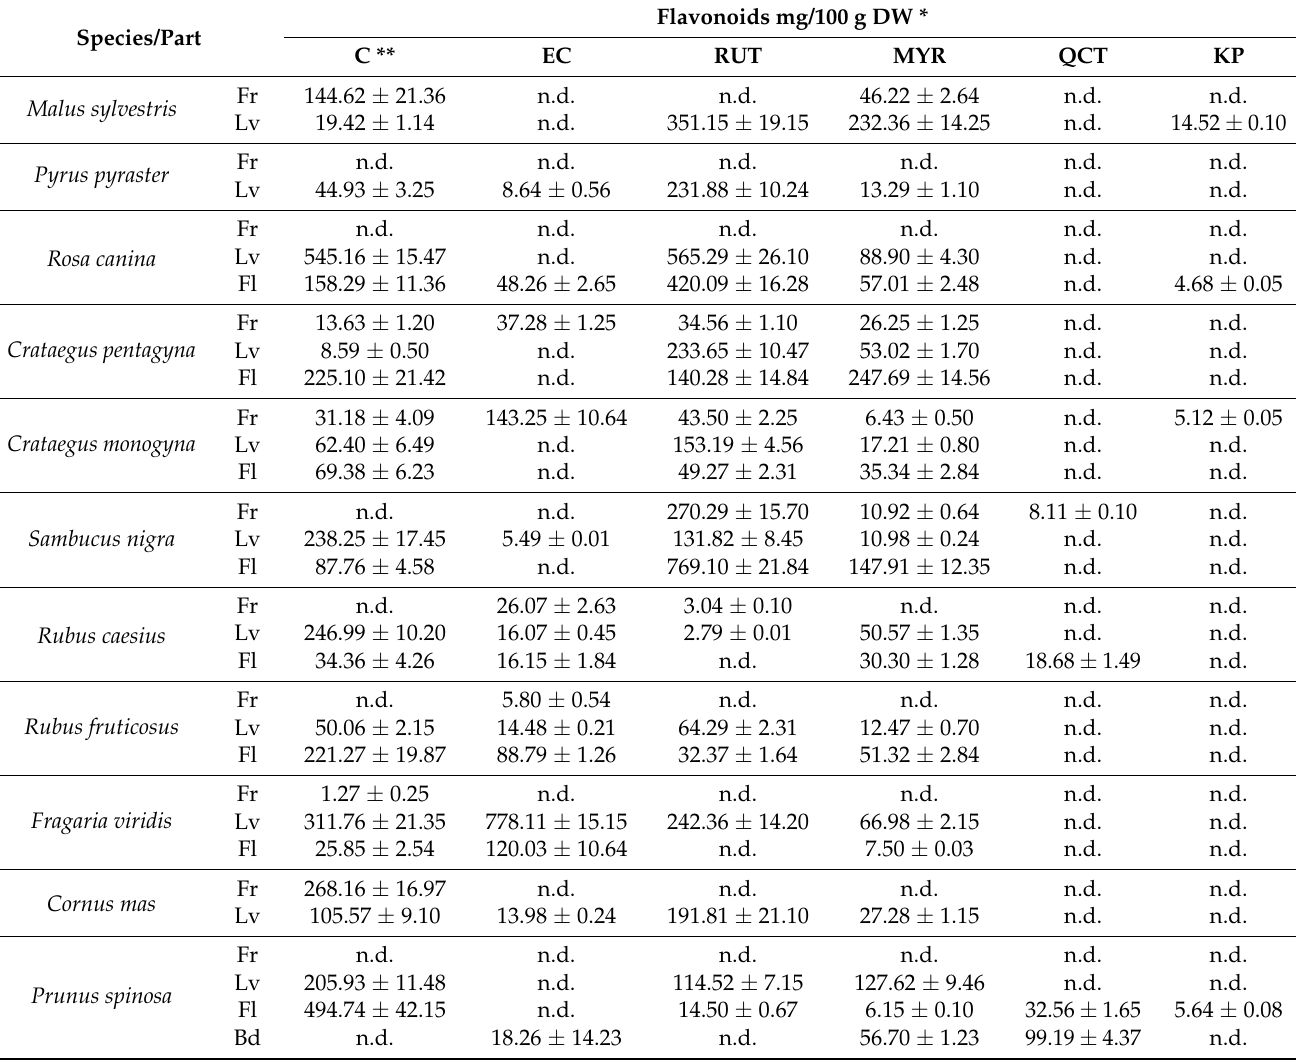
Table 1. Flavonoid content of studied wild fruit species in different plant